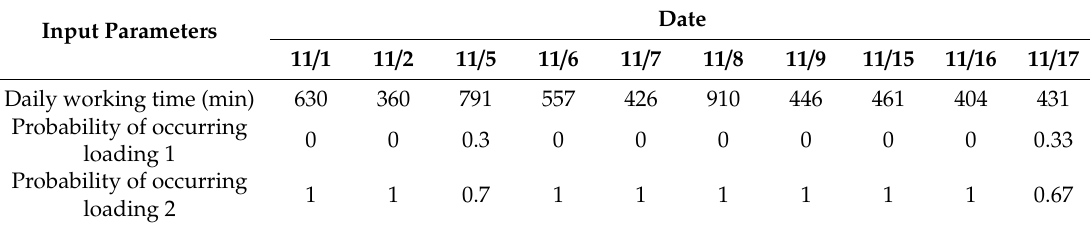
Table 5. Description of input node setting of optimal DNN model for predicting ore production and crusher utilization over 10 working days.